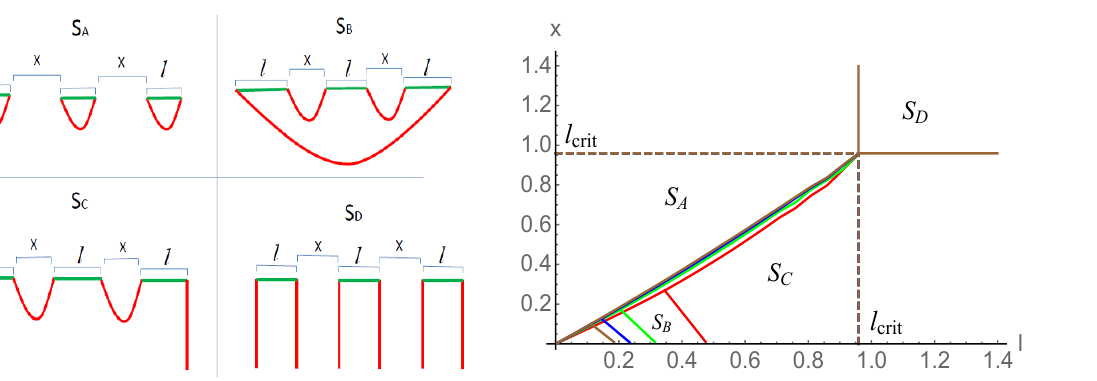
Figure 10 . Illustration of the four di(cid:11)erent minimal area surfaces for three strips of equal lengths ‘ and separation x in the thermal-AdS background. Similar minimal area surfaces ap- pear for higher n as well.